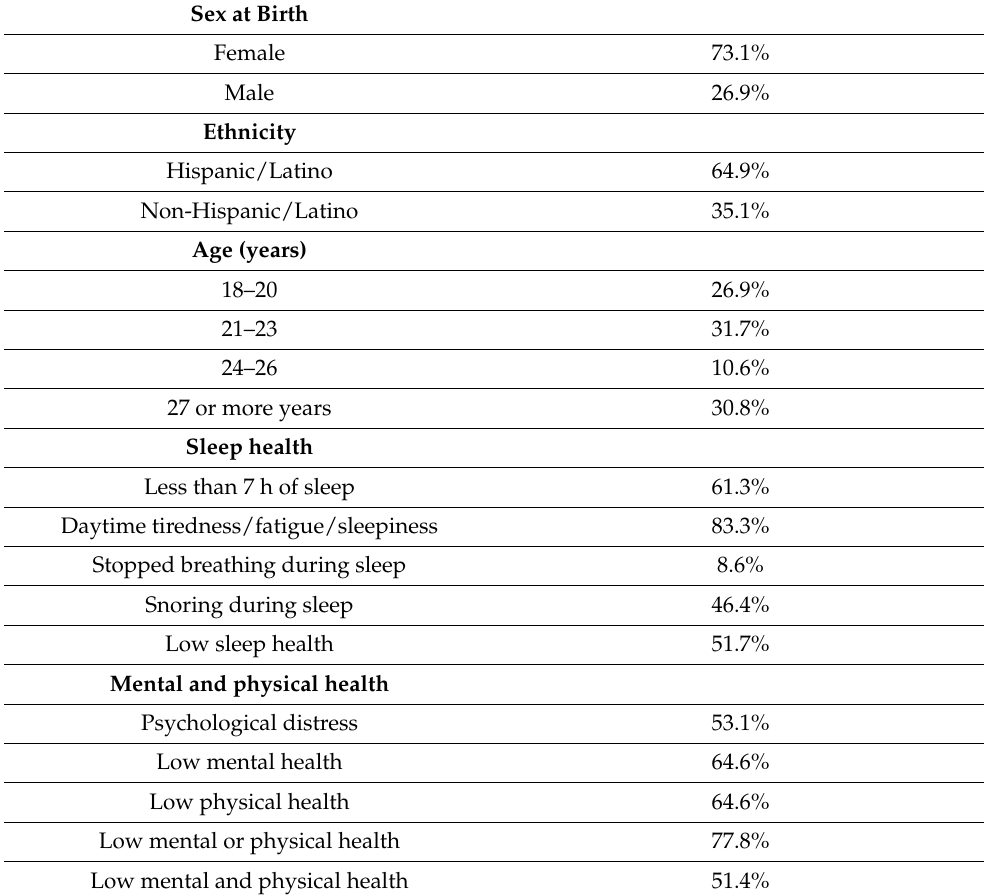
Table 1. Study population